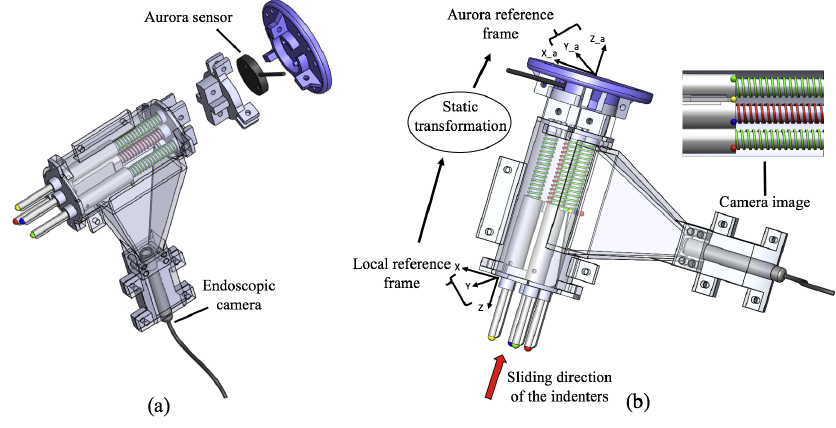
Figure 3. Stiffness probe integrated with a commercially available tracking system: ( a ) Exploded view of the sensor showing the position of the Aurora tracker. ( b ) Schematic representation of the sensor’s working principle: the interaction with external objects generates the sliding of the indenters, hence, the visual features change their positions in the camera’s image. The correlation between the indenters and the features allows to measure the new positions of the indenters in the local reference frame. A static transformation maps the new positions of the indenters from the local frame into the tracker